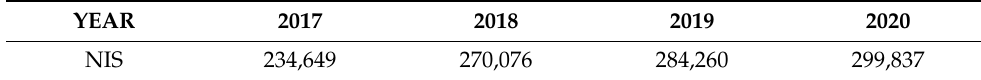
Table 17. Number of individual customers in